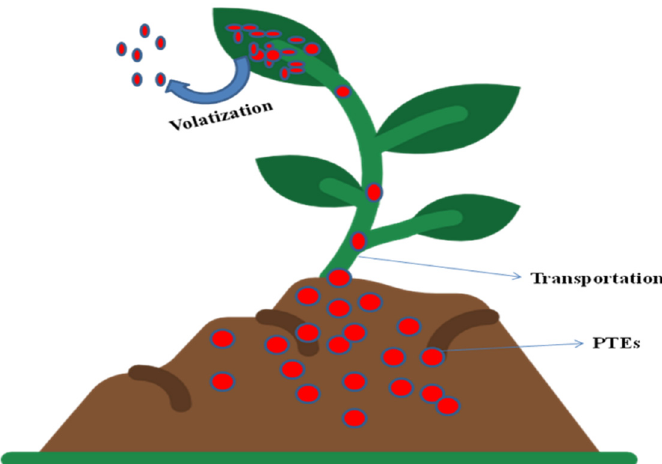
Figure 7. Major mechanisms underlying phytovolatilization